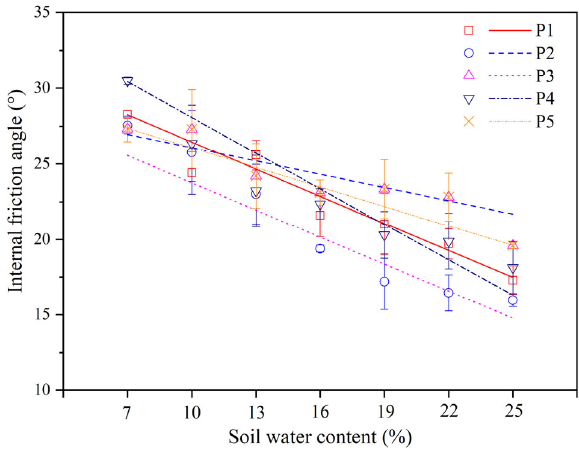
Figure 7. Internal friction angle with respect to the soil water content for different sample points (P1, P2, P3, P4, and P5).